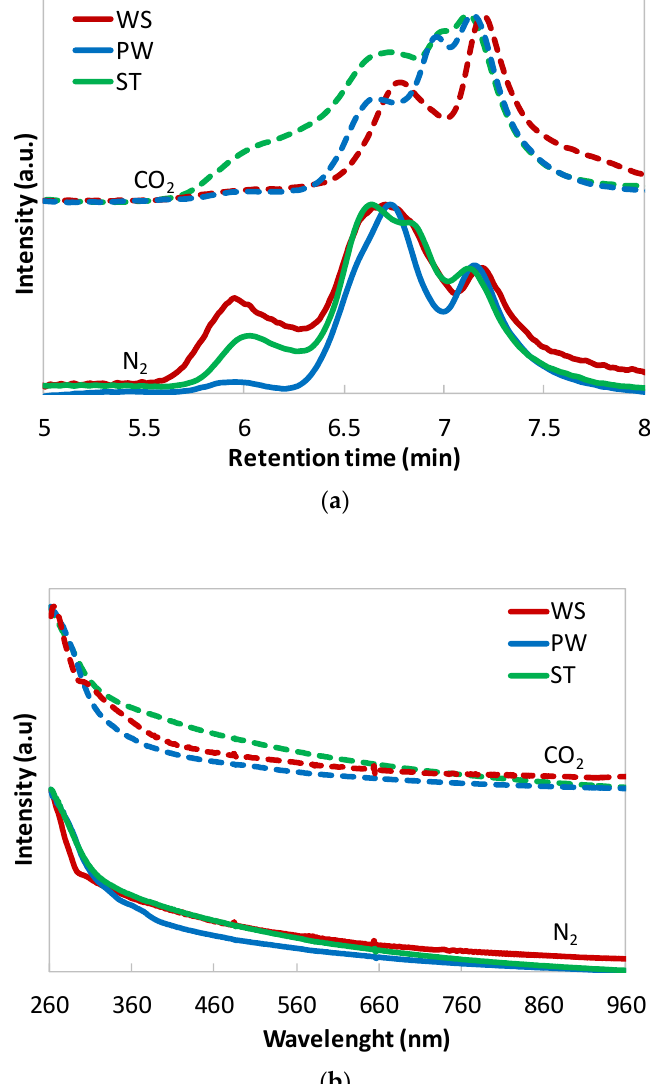
Figure 4. Analysis of heavy tar samples: ( a ) Size exclusion chromatography (SEC) chromatograms; ( b ) UV-Vis spectra.